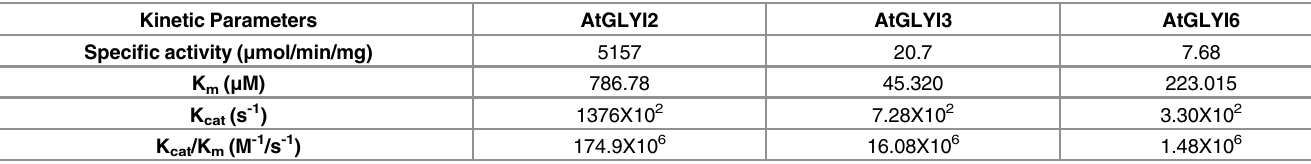
Table 1. Kinetic parameters calculated for AtGLYI enzymes of Arabidopsis thaliana